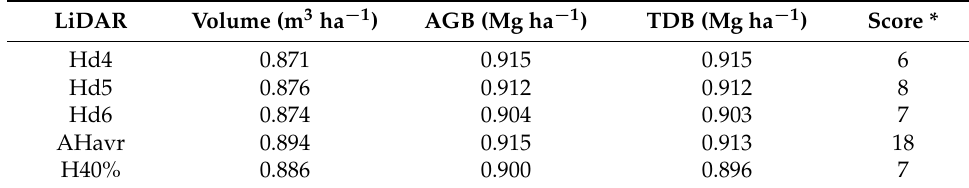
Table 4. Correlation coefficients between LiDAR and stand variables—Evergreen conifer (n =